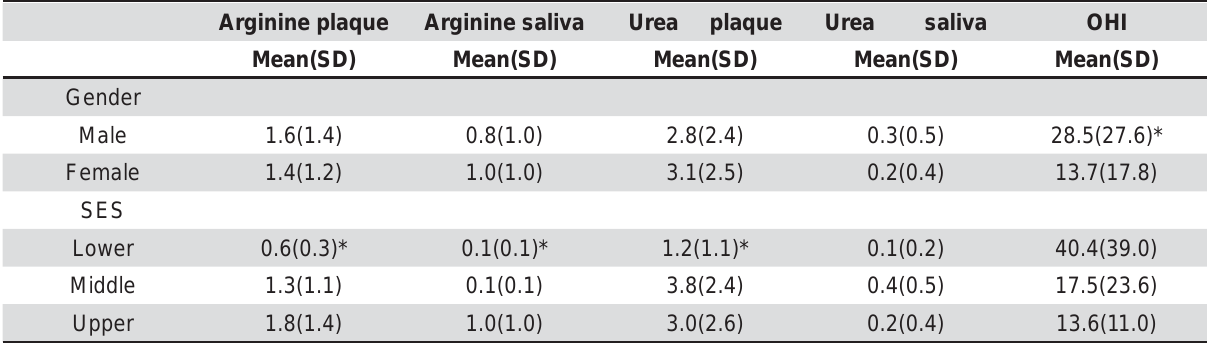
Table 3- Summary of mean alkali production# and oral health index according gender and socio-economic status (SES) (n=52)